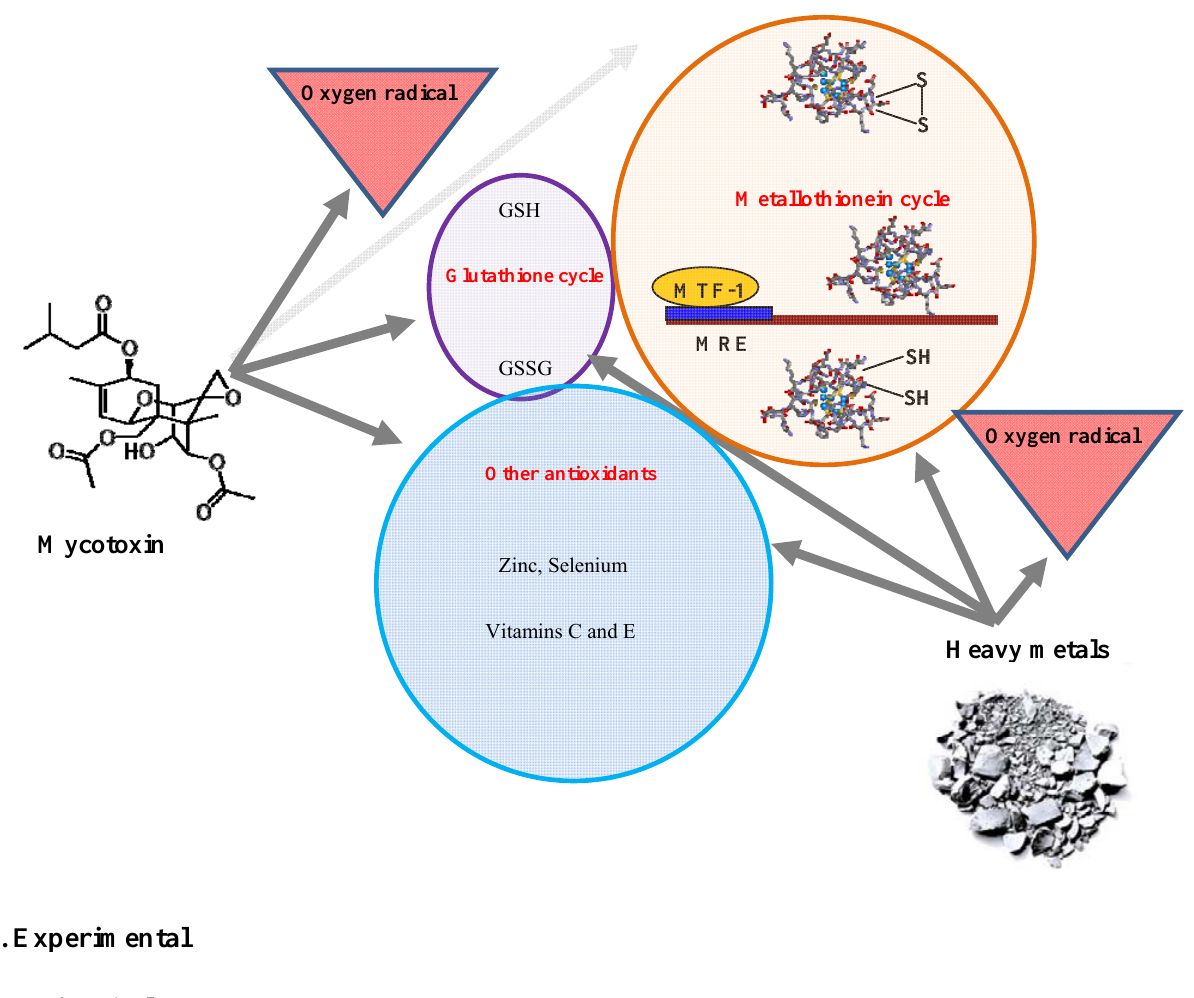
Figure 9. Simple scheme of mycotoxins affecting of MT synthesis. Mycotoxins produce oxygen radicals, which are scavenged by various mechanisms including MT